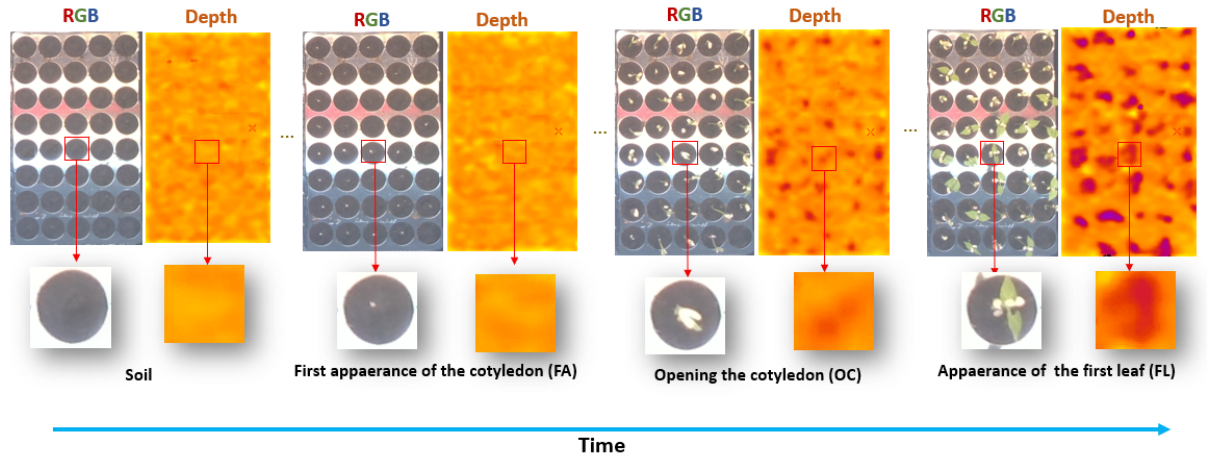
Figure 1. Overview of the time-lapse collected for this work. Upper row, view of a full tray with 72 pots from top view. Lower row, a zoom on a single pot at each stage of development to be detected from left to right: soil, first appearance of the cotyledon (FA), opening the cotyledons (OC) and appearance of the first leaf